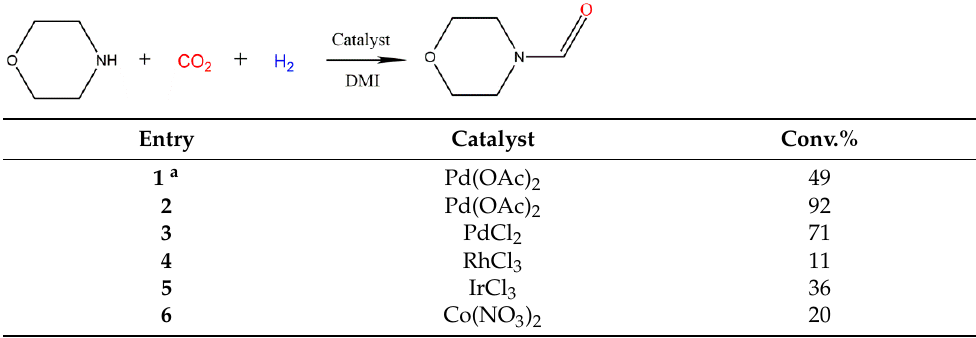
Table 1. Catalytic performance of metal catalysts for N-formylation reaction.